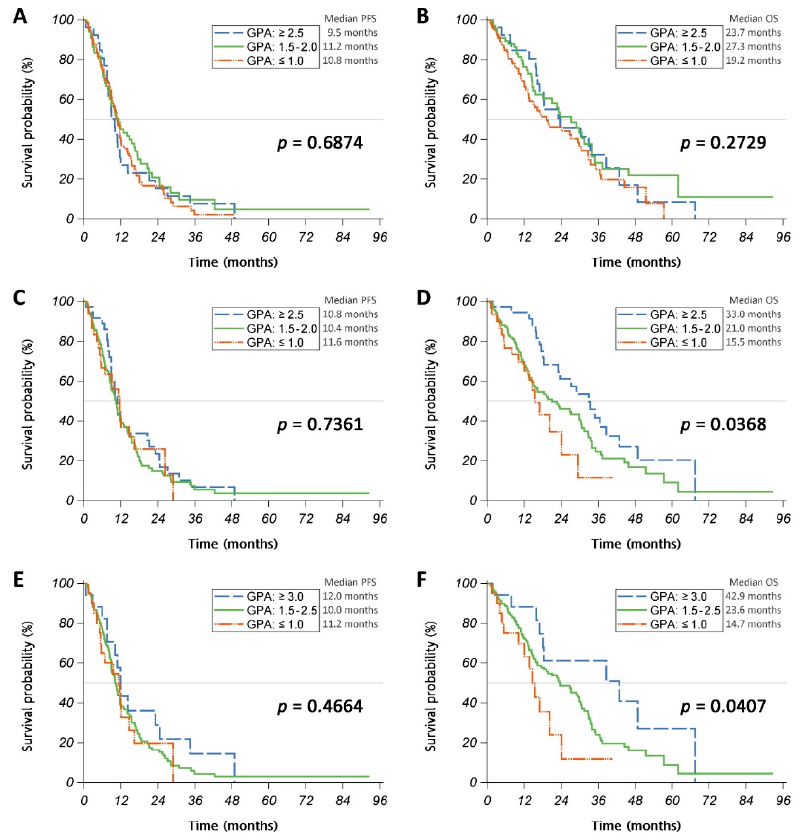
Figure A3. ( A , C , E ) Progression-free survival (PFS) and ( B , D , F ) overall survival (OS) of patients classified by the ( A , B ) 2010, ( C , D ) 2017, and ( E , F ) 2022 versions of the graded prognostic assessment (GPA). Table A1. Graded prognostic assessment (GPA) index of patients with newly diagnosed lung adenocarcinoma with brain metastases. Version